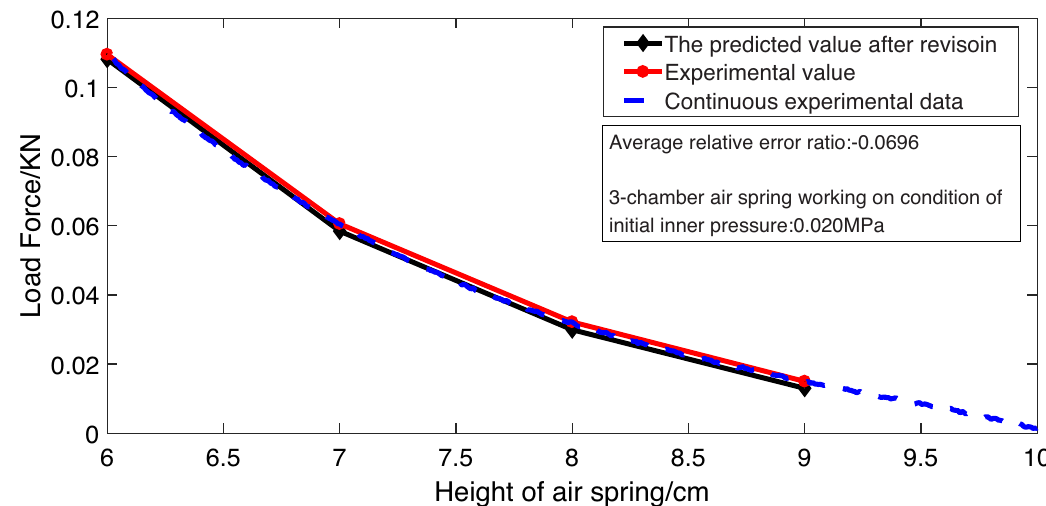
Fig. 13. Measured values and predicted values with modifying